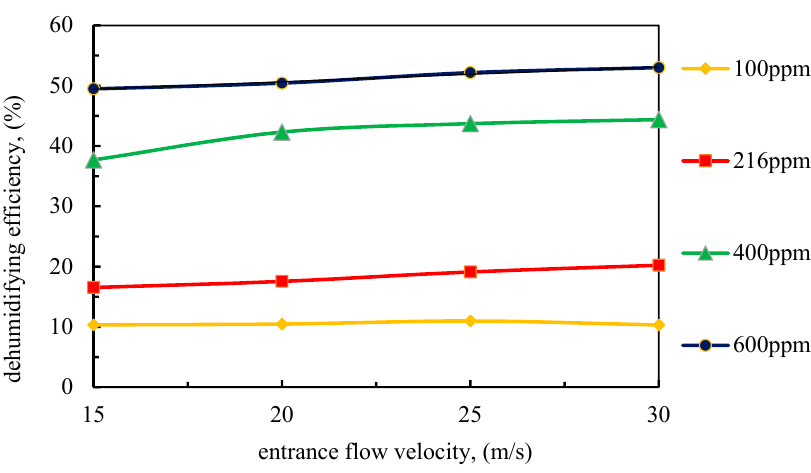
Figure 5. Change regularity of dehumidification efficiency under different entrance flow velocities.